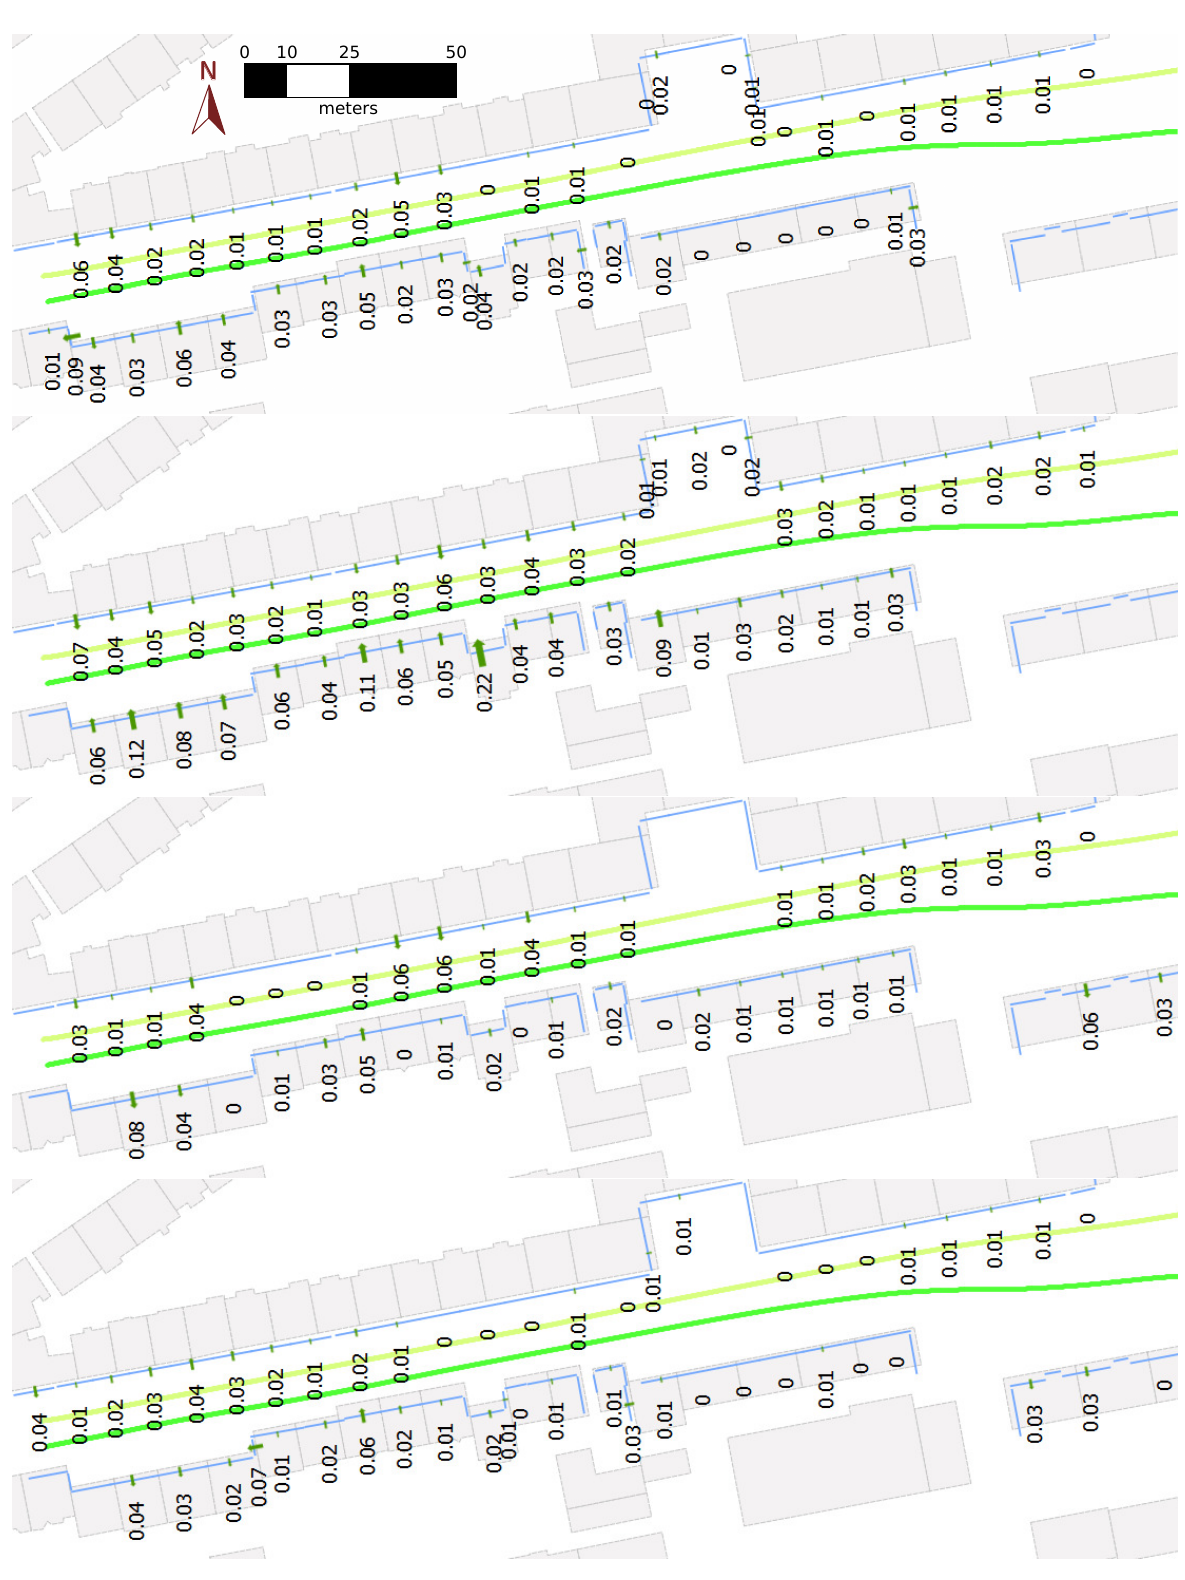
Figure 19. Facade errors after the proposed optimization in the Dortmund 2 dataset. From top to bottom: left sensor in the first pass compared to the left sensor in the second pass; left sensor in the first pass compared to the right sensor in the second pass; right sensor in the first pass compared to the left sensor in the second pass; right sensor in the first pass compared to the right sensor in the second